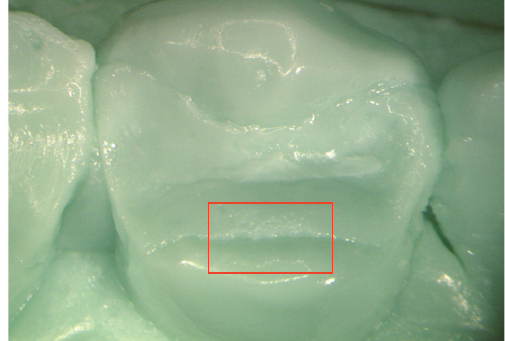
Figure 5: Epoxy replica of a Ketac Molar filling after 12 months. A distinct crevice is evident.